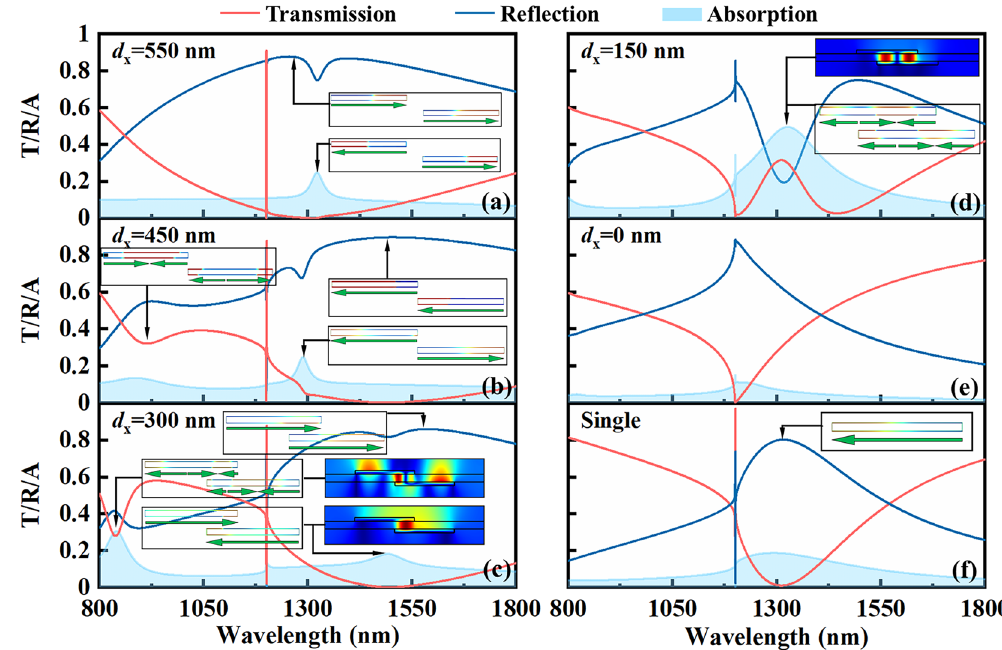
Figure 3. The transmission (red solid lines), reflection (blue solid lines) and absorption (cyan shaded area) spectra of the plasmonic waveguide structure for TM polarization and normal light incidence with the lateral shift d x = 550 nm ( a ), 450 nm ( b ), 300 nm ( c ), 150 nm ( d ), and 0 nm ( e ). The charge and magnetic field distributions at some specified locations are shown in the inset for clearly determining the origins of resonate modes. The transmission, reflection and absorption spectra of the structure consisting of single layer nanowire grating and waveguide are given as a direct comparison in panel ( f ). Insets in panel ( f ) corresponds to the charge distribution of reflection